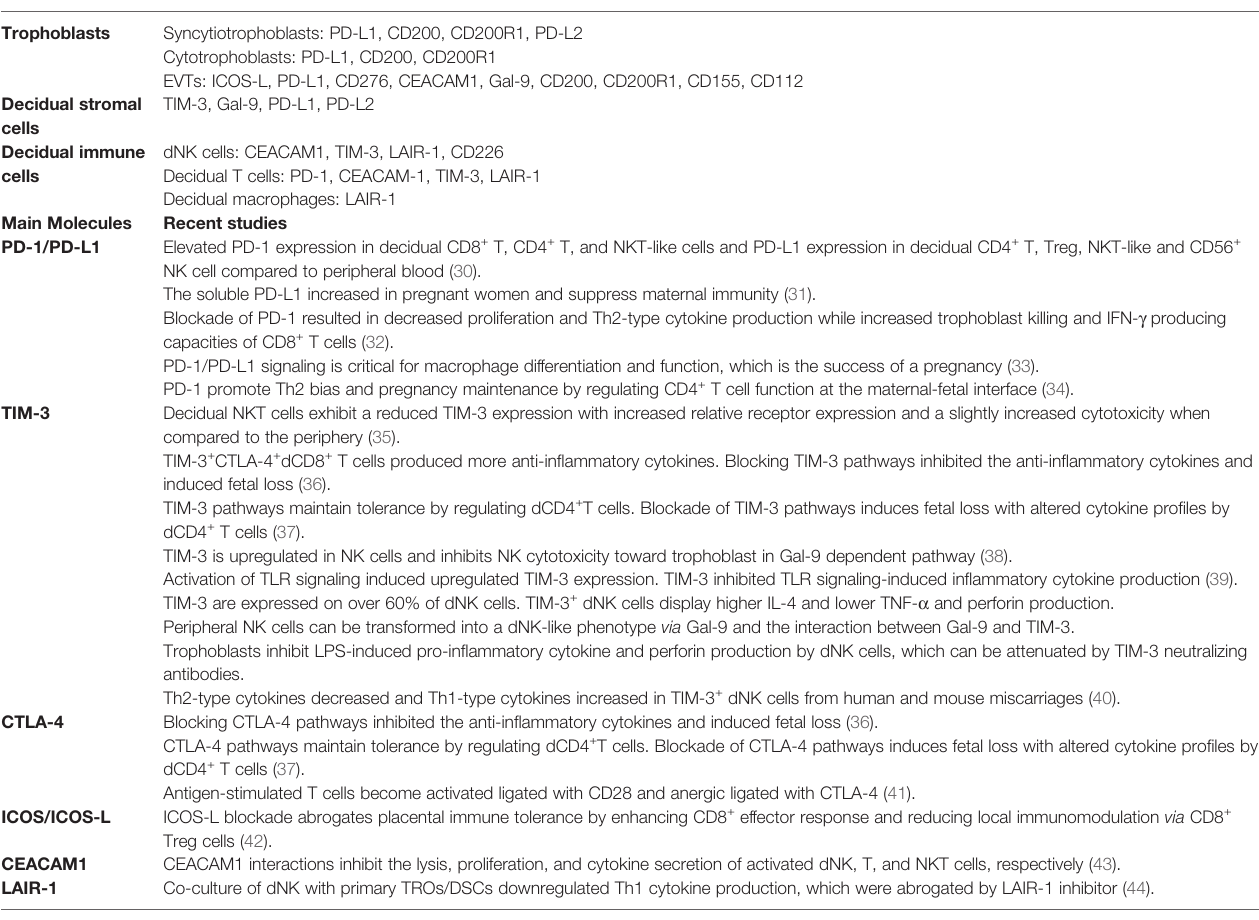
TABLE 1 | Co-signaling molecules and their mechanism to induce the maternal-fetal immune tolerance. Cells Co-signaling Molecules